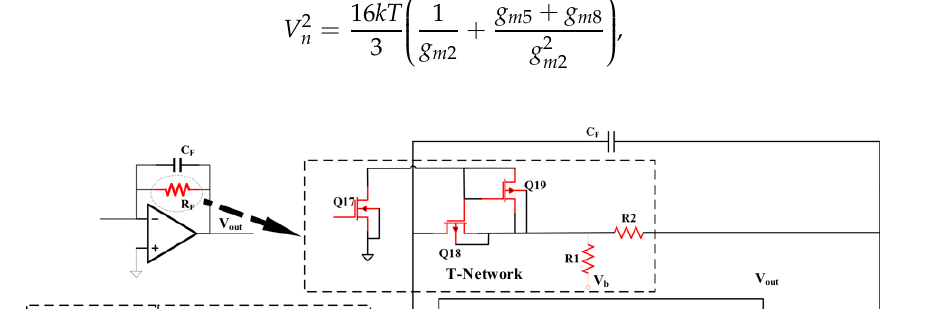
Figure 8. Transimpedance structure of charge voltage conversion circuit